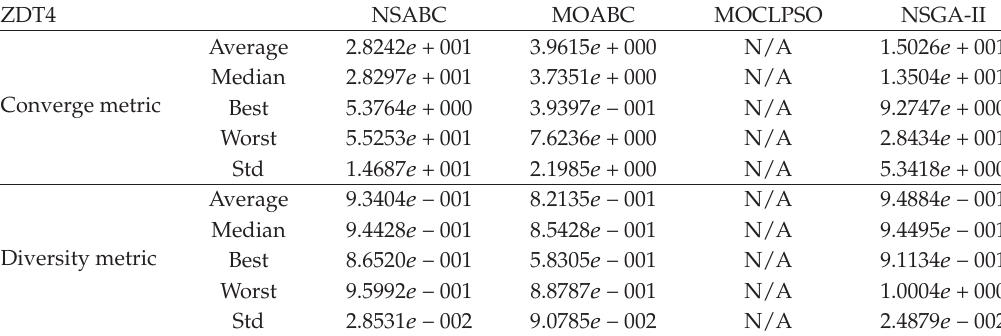
Table 12: Comparison of performance on ZDT4 after 20000 FEs.